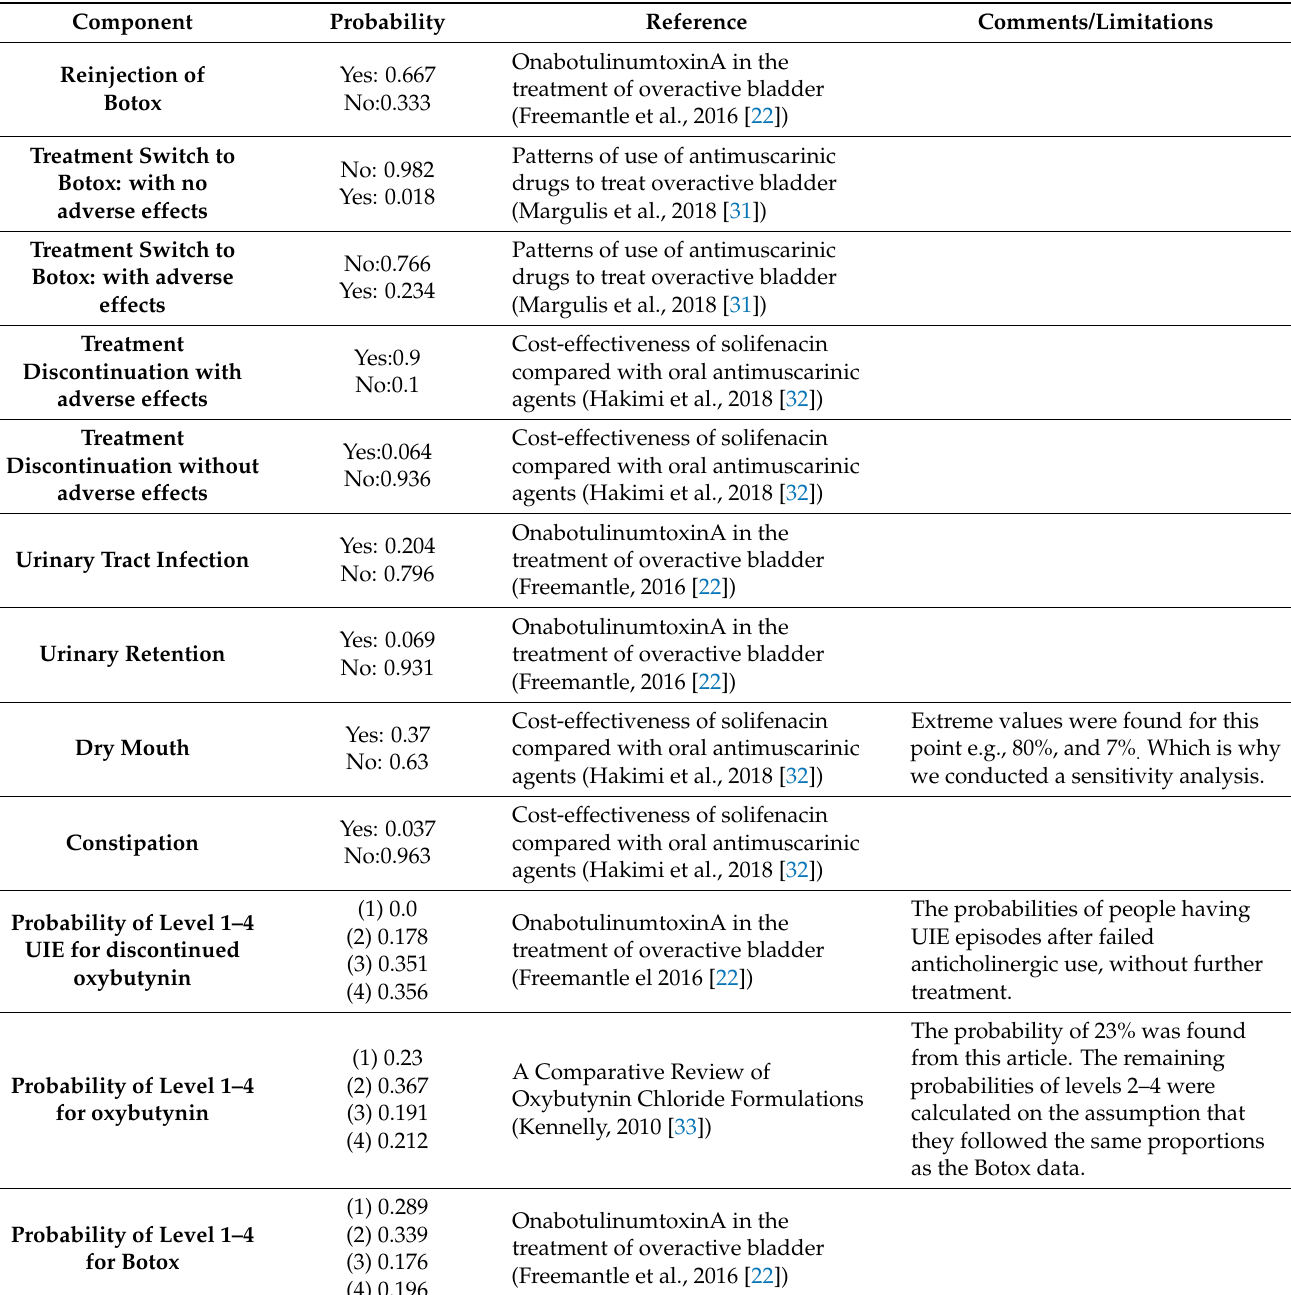
Table A6. Probabilities used in the decision